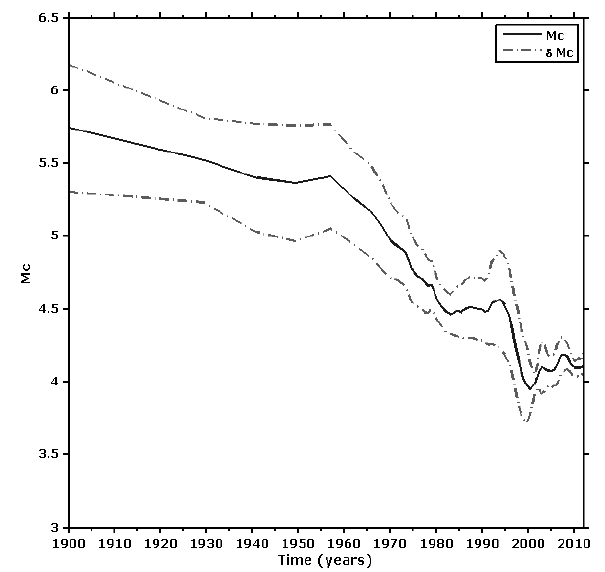
Figure 17. Variations of magnitude of completeness (M for instrumental earthquakes in Iran.